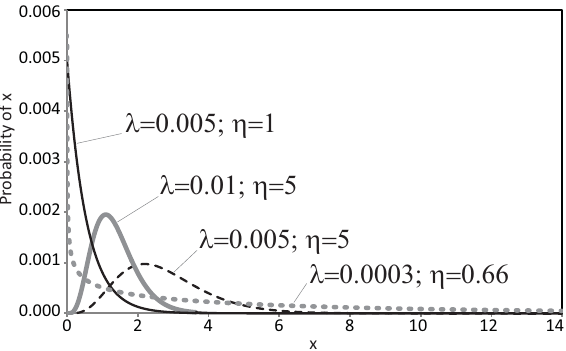
Figure 2. Gamma functions for different values of the two shape